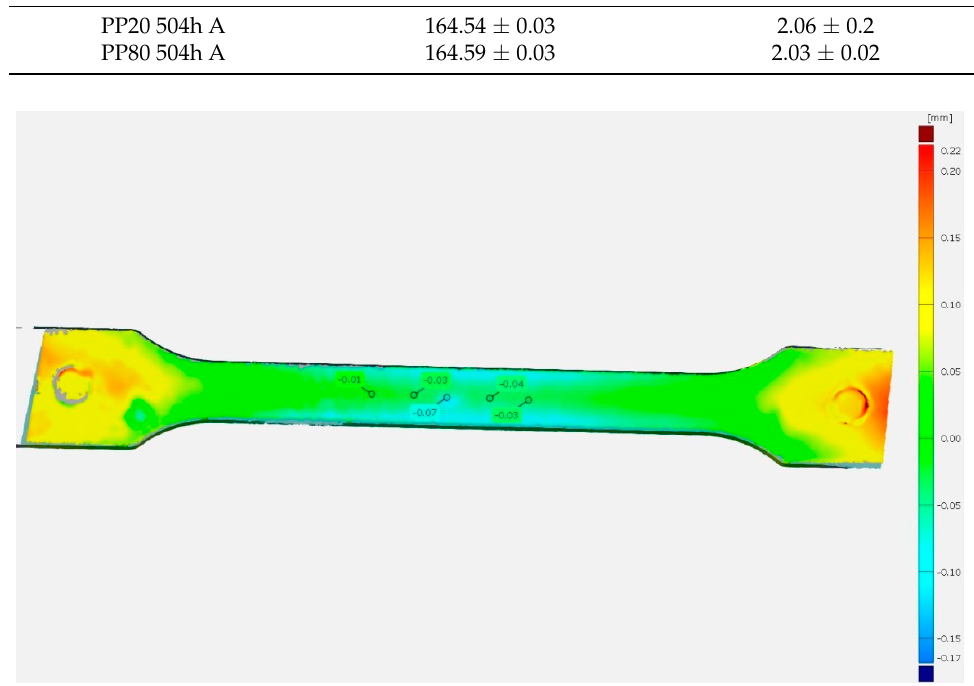
Figure 3. Comparison of the PP20 sample surface (reference) with the PP80 sample after 1 h of conditioning; positive deviation (red), negative deviation (blue). conditioning; positive deviation (red), negative deviation (blue).